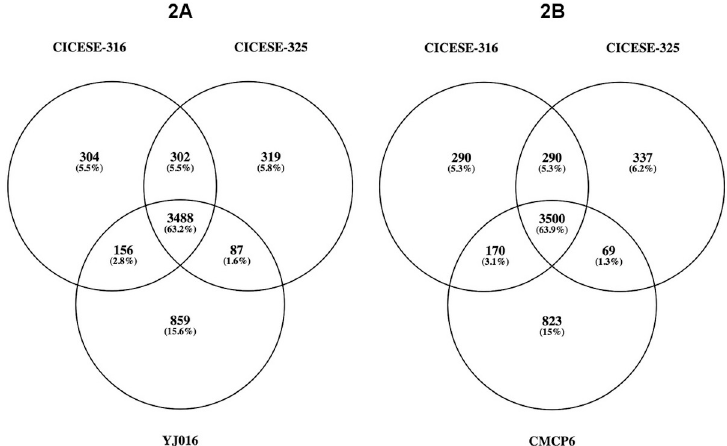
Fig 2. Venn diagram representing not-shared and common genes among CICESE-316 and CICESE-325, related to YJ016 (2A) and CMCP6 (2B).